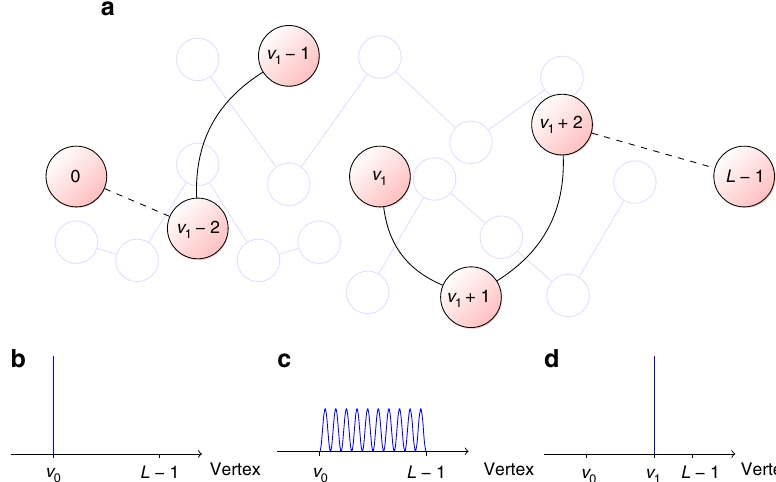
Fig. 6 Solving OEOTL by FF. Let H G be the adjacency matrix of the graph G , and denote by 0, 1, … , L − 1 the consecutive vertices of the line ( L − 1 is the OEOTL). The panels show the probability distribution of the states in the fi rst iteration of the algorithm. b The initial node v 0 = 0. c H 0 can be FF